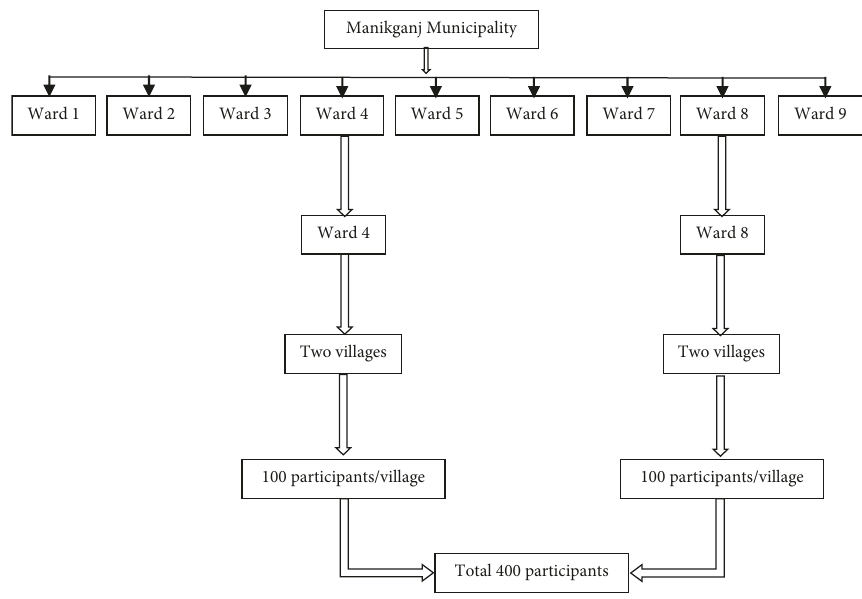
Figure 1: Multistage cluster